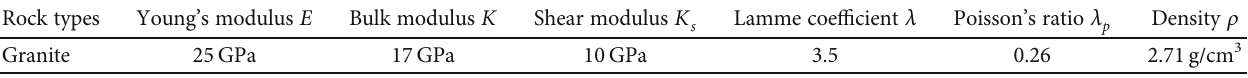
Table 7: Material parameters of granites.